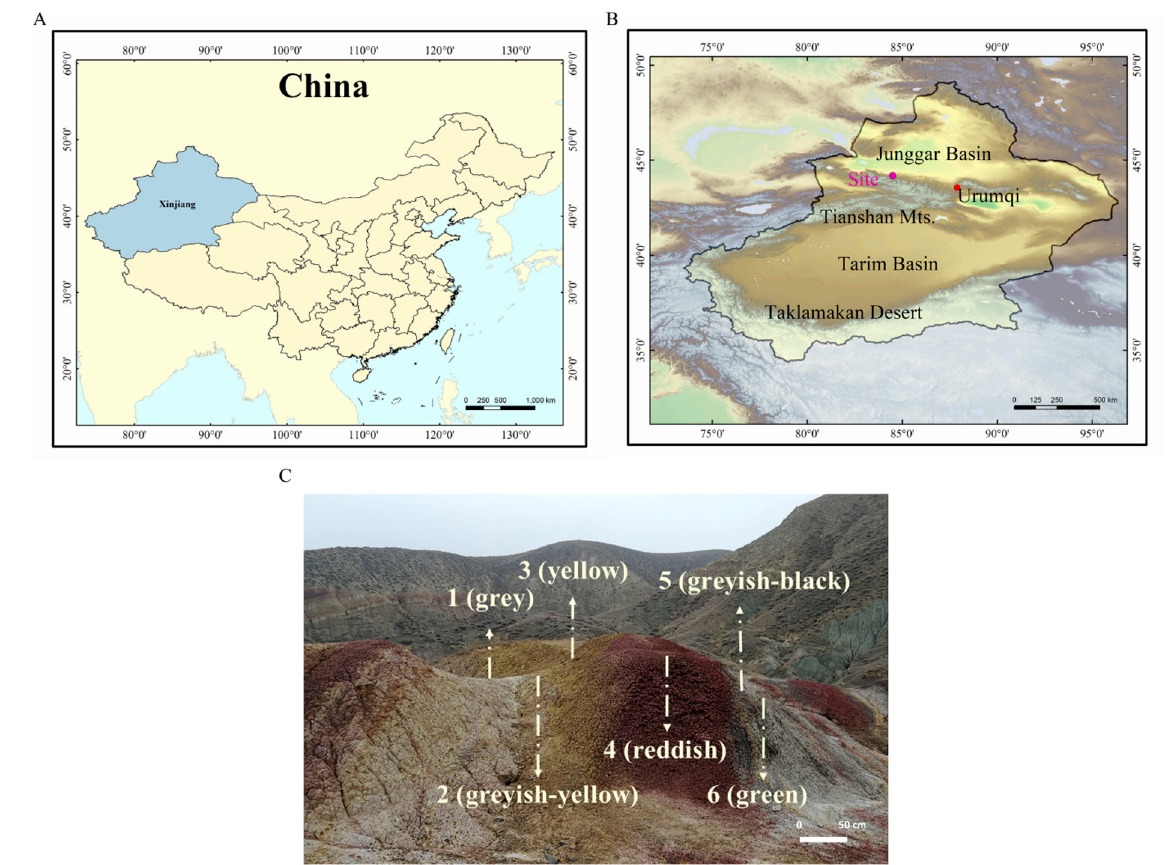
Figure 1. Location of research sites along the southern margin of the Junggar Basin. ( A ) The blue shading shows the boundary of Xinjiang Uyghur Autonomous Region. ( B ) Some of the characteristic sites and our sampling site are shown in the Xinjiang Uyghur Autonomous Region. ( C ) The geological features of the six colored layers sampled. AQG1: gray, AQG2: grayish-yellow, AQG3: yellow, AQG4: reddish, AQG5: grayish-black, AQG6: green.